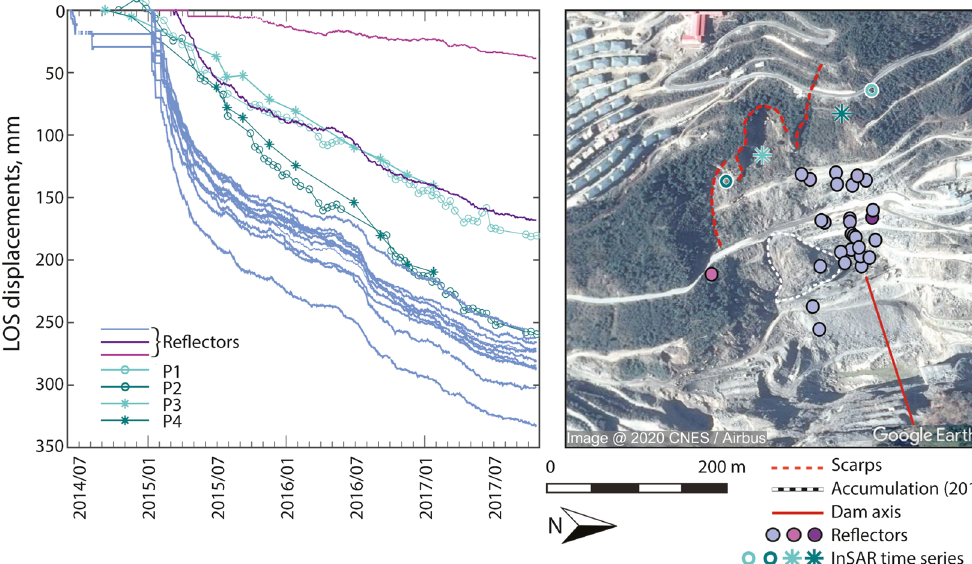
Figure 4. Left: comparison between in-situ data (solid lines) and satellite-based time series (lines with markers). Right: area of 2013 and 2016 failure with location of total station reflectors and sampling points of satellite observations (Background Google Earth CNES/Airbus